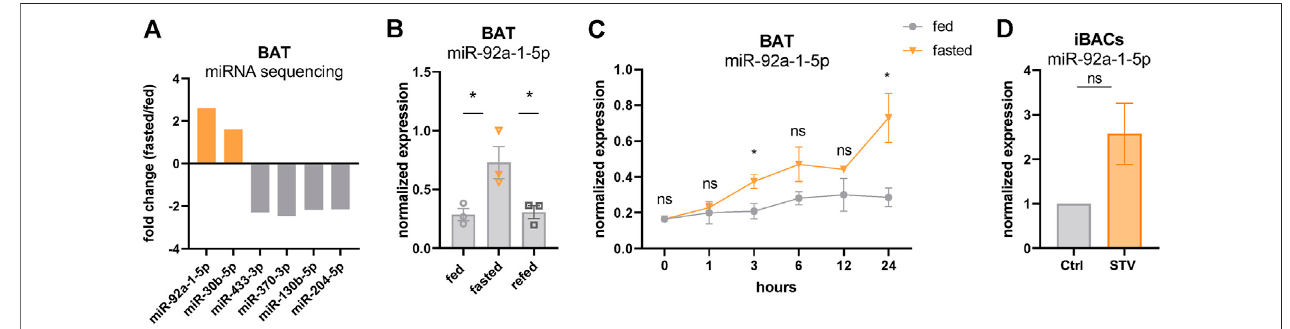
FIGURE3| miR-92a-1-5pisupregulatedinfastedBAT. (A) Topup-anddownregulatedmiRNAsin24 hfastedBATdeterminedbymiRNAsequencing( n =3). (B) Expression of miR-92a-1-5p in BAT of ctrl, 24 h fasted, and refed mice validated by qPCR. (C) Time-series of miR-92a-1-5p expression in BAT harvested after 1, 3, 6, 12, and 24 h of fasting in mildly cold-stressed mice. As control, BAT was harvested from ad libitum fed mice at the respective circadian-matched time points ( n = 3). (D) ExpressionofmiR-92a-1-5pindifferentiatediBACscultivatedingrowthmediumorstarvedfor24 h( n =3).Meanvalues±SEMareshown,signi fi cantdifferencesin the mRNA expression of fed, fasted and refed mice were analyzed by 2-way ANOVA and Tukey ’ s multiple comparisons test. For in vitro data, unpaired t-test was performed. Differences not indicated with asterisks or indicated with ns are not statistically signi fi cant ( p > 0.05). * p < 0.05.